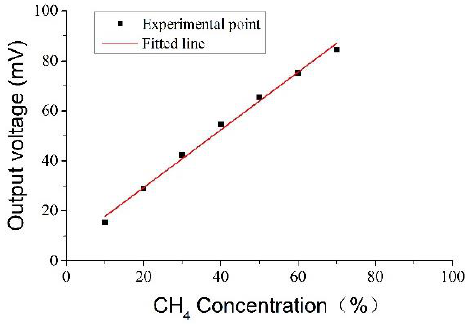
Figure 8. Sensor response to various methane concentrations with a linear fit.